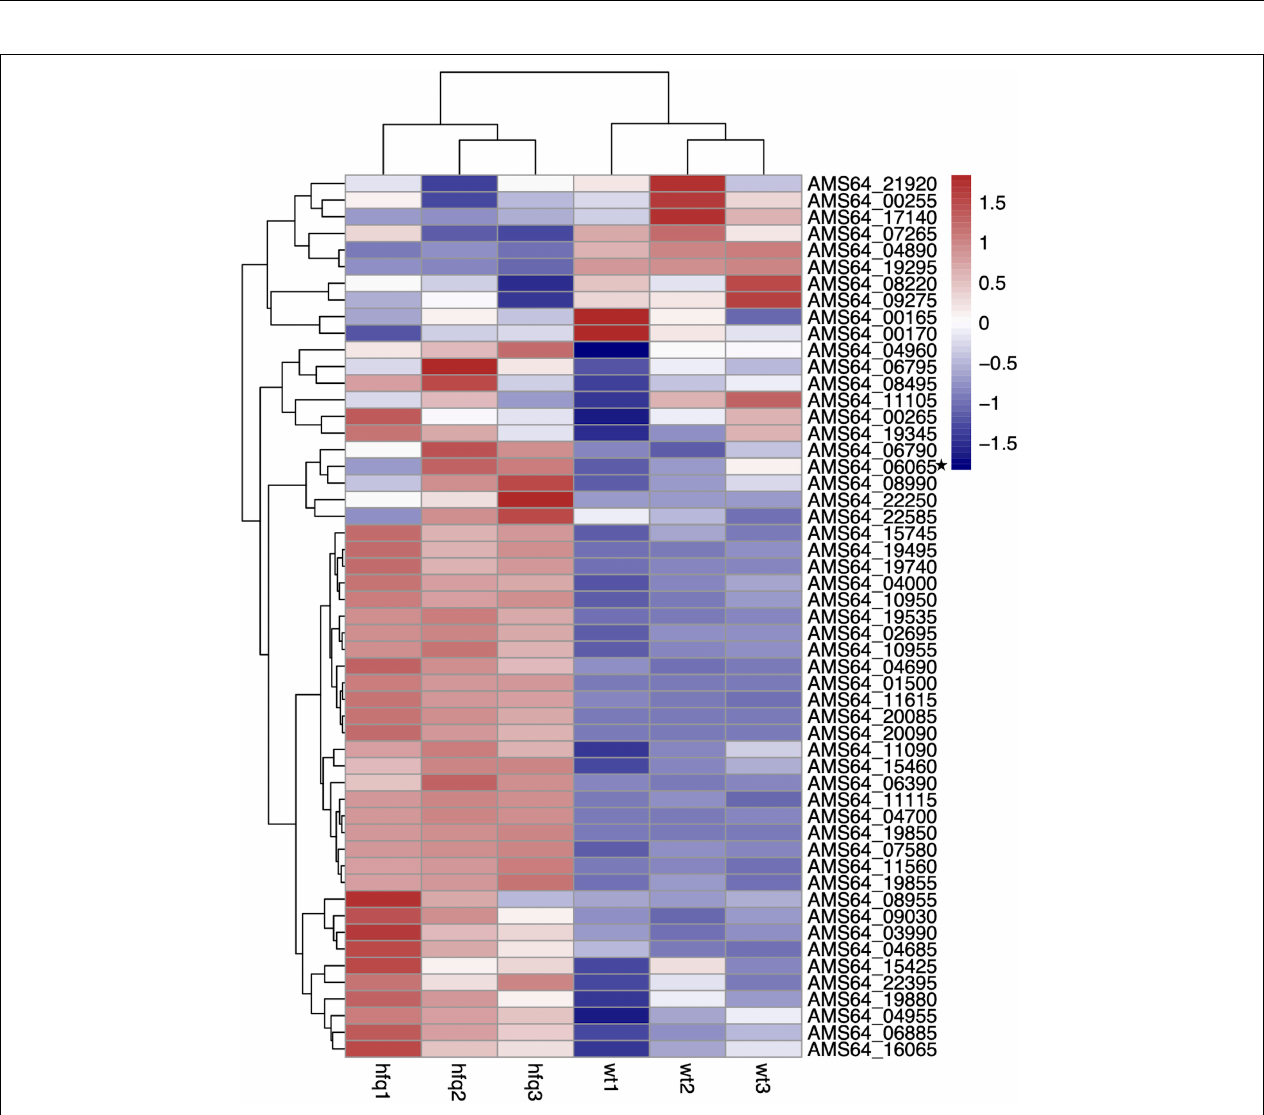
FIGURE 2 | Transcriptomic data of Aeromonas veronii . Heat map of expression levels of genes involved in purine metabolism and efflux pump synthesis of wild-type and (cid:49) hfq strains.